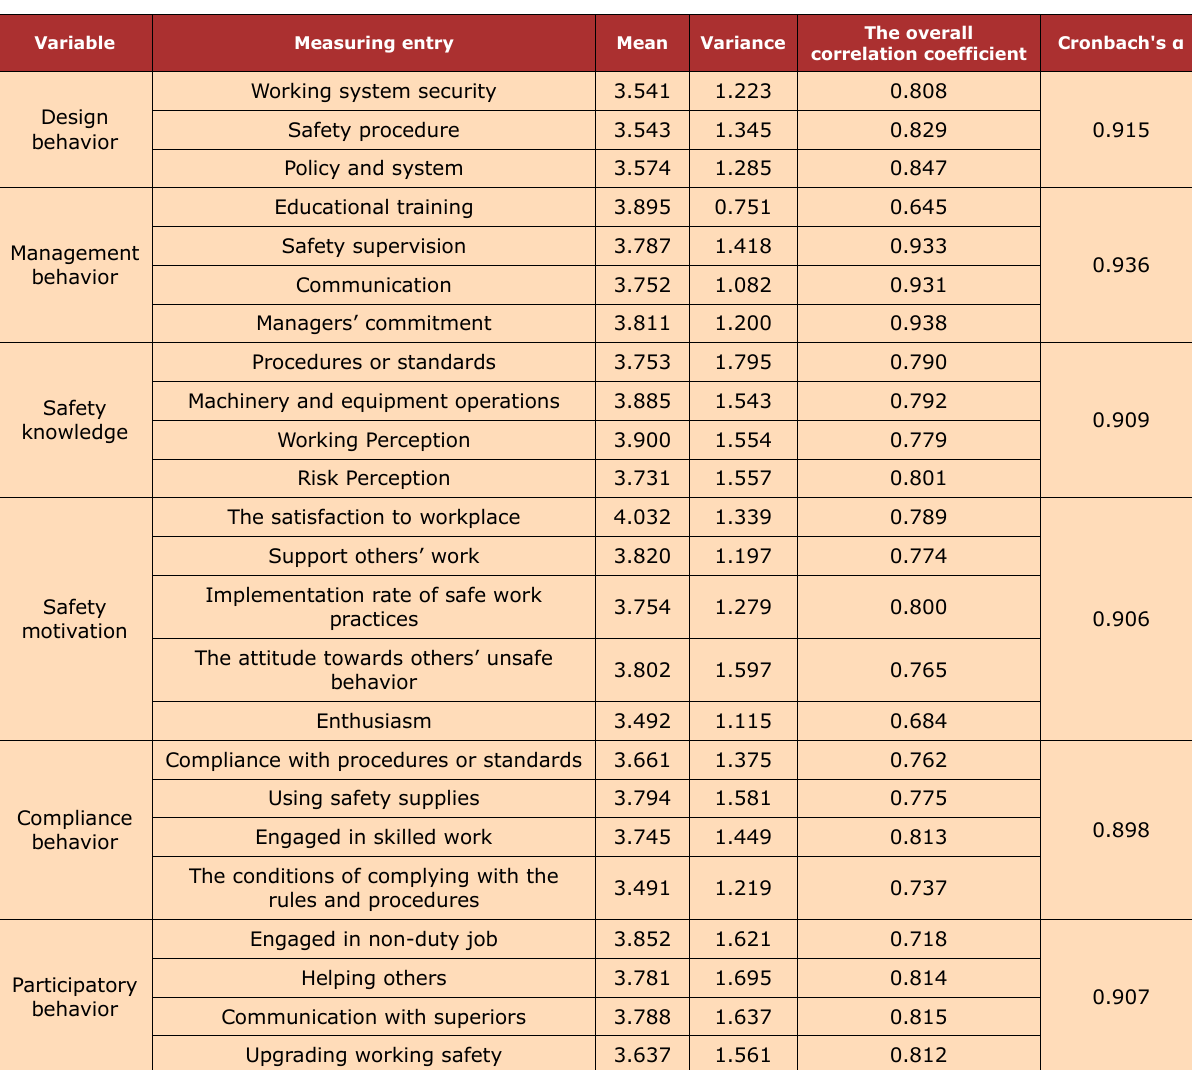
Table 3. Variables Statistics and Reliability AnalysisConfirmatory factor